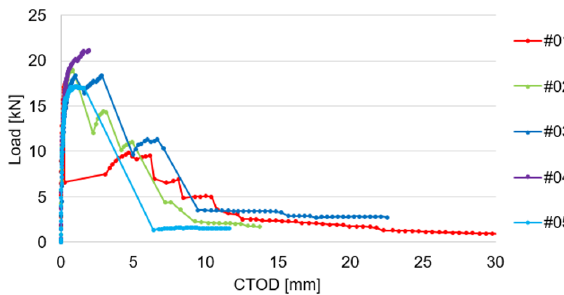
Figure 6. Load vs. crosshead displacement of the group one beams with the first failure F1 - splinter around the ligament.